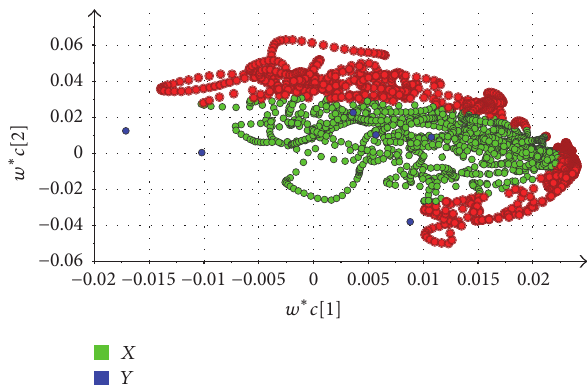
Figure 6: The loading scatter plots for UHPLC, “ 𝑋 ” represents the information obtained by UHPLC chromatographic peaks and “ 𝑌 ” represents the six species of Paris . Marked spots represent the importance of composition for clustering that VIP above 1. The abscissa represents the weights for the first components and the ordinate represents the weights of the second